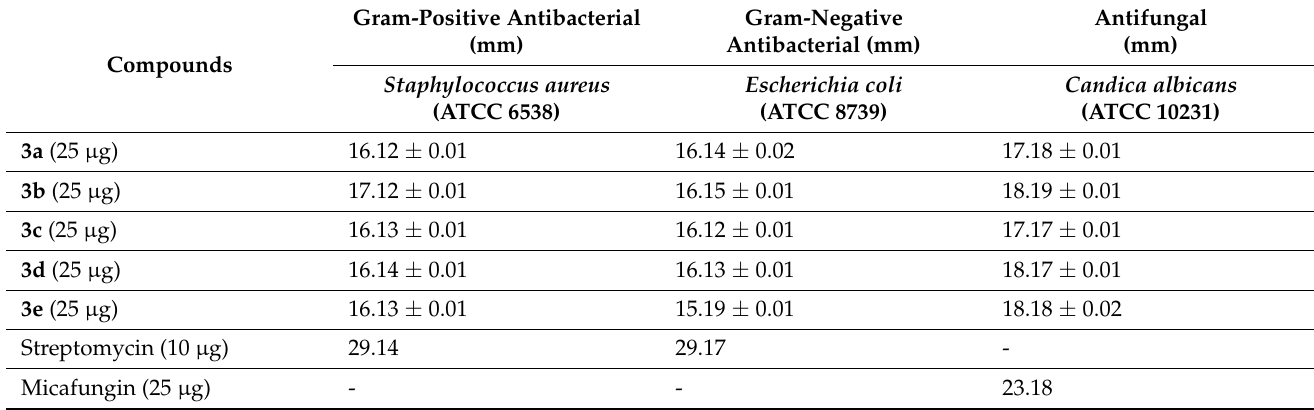
Table 4. The result of antibacterial and antifungal